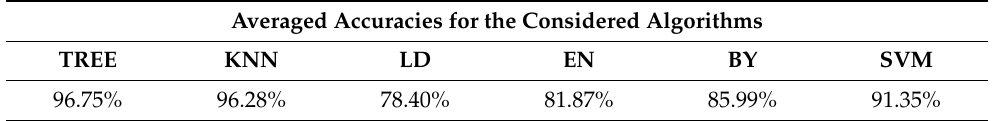
Table 7. Average over accuracies calculated for particular algorithms. Averaged Accuracies for the Considered Algorithms TREE KNN LD EN BY SVM 96.75% 96.28% 78.40% 81.87% 85.99%